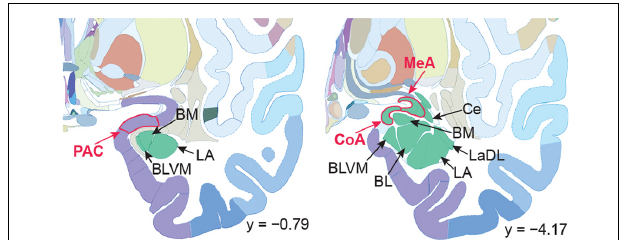
FIGURE 1 | Human brain atlas with subregions of the amygdala labeled. Subregions that receive olfactory bulb input are labeled in red; others are labeled in black. Olfactory subregions include the medial amygdala (MeA), cortical amygdala (CoA), and the periamygdaloid complex (PAC). Other amygdala subregions listed for reference: the lateral amygdala (LA), ventromedial part of the basolateral amygdala (BLVM), basomedial amygdala (BM), central amygdala (Ce), and the dorsolateral part of the lateral amygdala (LaDL) (adapted from Mai et al.,